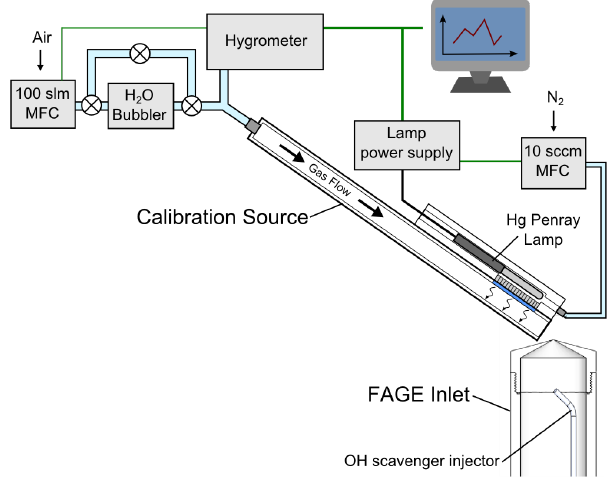
Figure 3. Schematic cross section of the H 2 O vapour photolysis cal- ibration source used in the calibration of the two FAGE instruments (inlet for HIRAC FAGE instrument shown here, for example). The [H 2 O] vapour was measured prior to entering the square cross- section flow tube, and the concentration was controlled through a series of three taps around the bubbler. The Hg Pen-Ray lamp was housed in a second section of the wand, and the output was colli- mated through a Suprasil window using a honeycomb arrangement of ø = 1mm aluminium tubes. The lamp was continuously flushed with N 2 to remove potential absorbers and photolabile species, and to help regulate